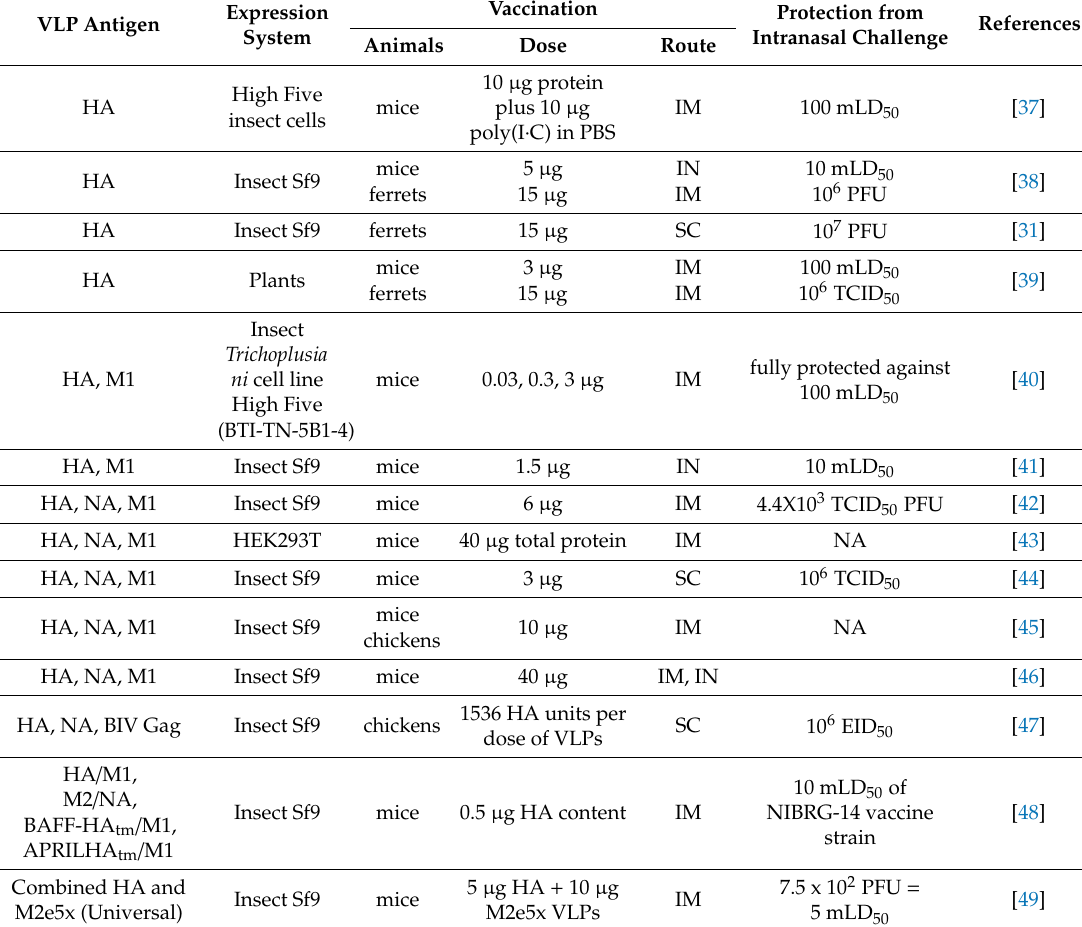
Table 2. Examples of virus-like particle (VLP) vaccines against H7N9